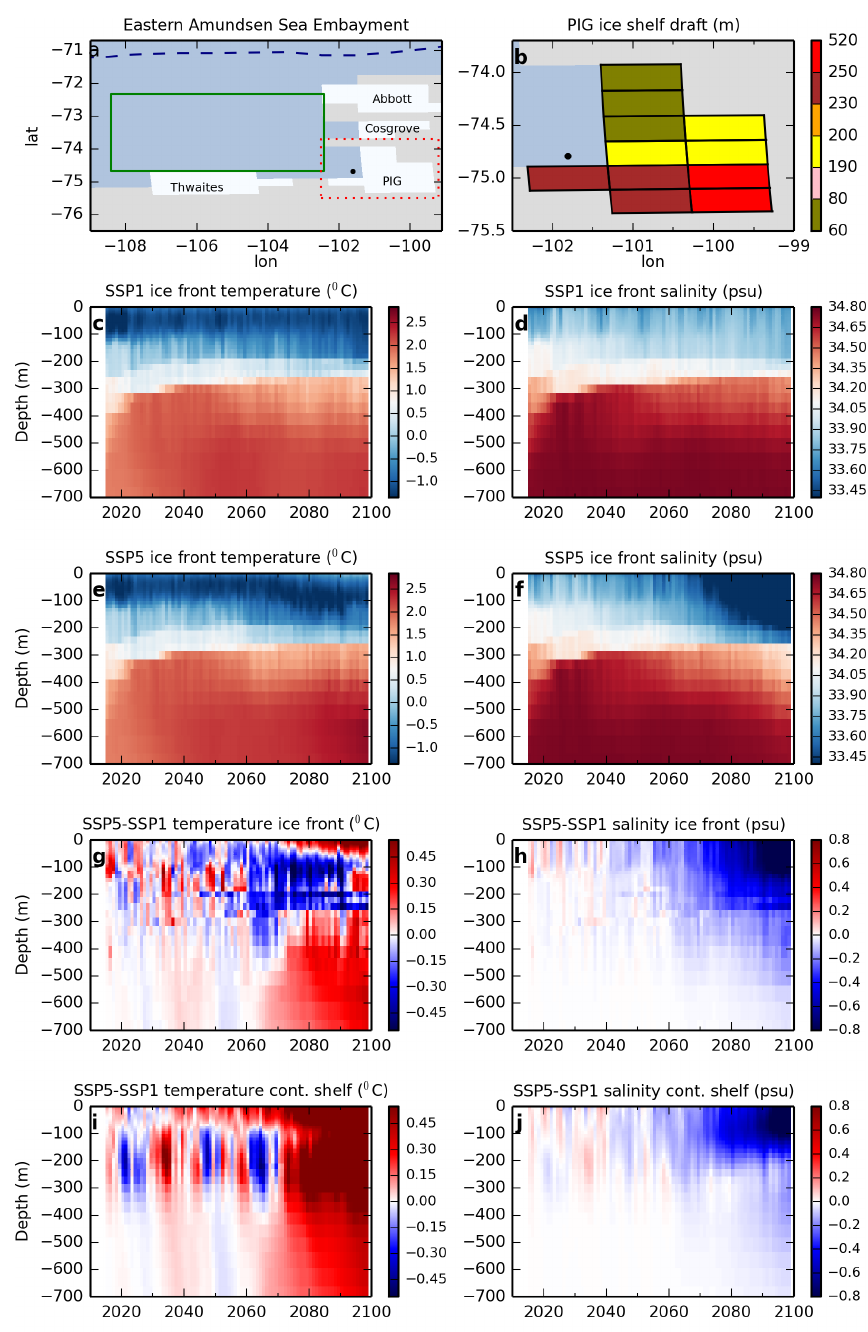
Figure 12. (a) The Amundsen Sea Embayment in the NEMO ORCA1 ocean model. Blue, grey and white colours denote the ocean, grounded ice sheet and ice shelf region. The dashed purple line marks the 700m isobaths as the continental shelf edges. The black dot indicates the ice front where the time series profile in (c) – (h) is located. Enclosed by the green box is the continental shelf region where the horizontal average of time series profile in (i) and (j) is taken from. (b) The enlarged area surrounded by red dotted line in (a) but now with the PIG Ice Shelf shaded with an ice shelf draft colour scale. The draft is taken from the year 2080 of one SSP5–8.5 ensemble member. (c–h) Time series at the PIG ice front of temperature and salinity: (c,d) SSP1–1.9 ensemble mean, (e,f) SSP5–8.5 ensemble mean, and (g,h) anomaly between SSP5–8.5 and SSP1–1.9 ensemble mean. (i,j) Like (g,h) but for the horizontal average over the area bounded by the green box in (a)